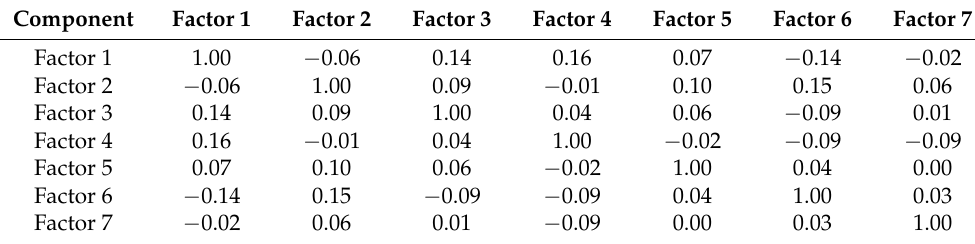
Figure 3. The screen plot for the initial PCA. The slope of the curve vaguely leveled off just after the 7th factor. Using eigenvalue-more-than-1 criteria would definitely take in more than 10 components/factors, which would not blend well the corresponding framework. Table 5. Correlation matrix table between the new factors during initial